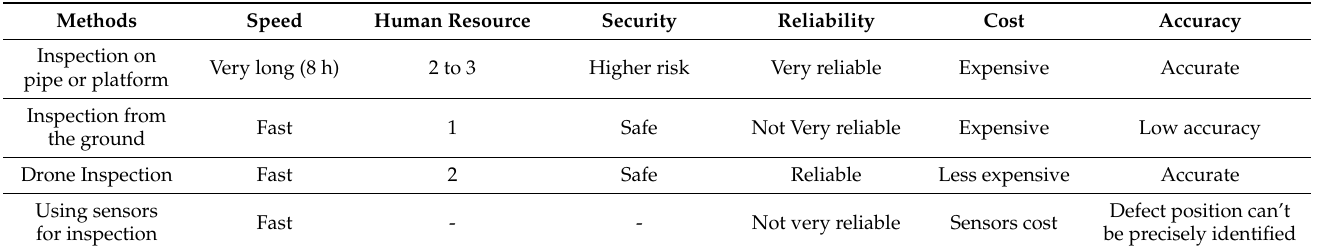
Table 2. Comparison of the different methods that are most commonly used to detect damage in WTBs that are in operation.